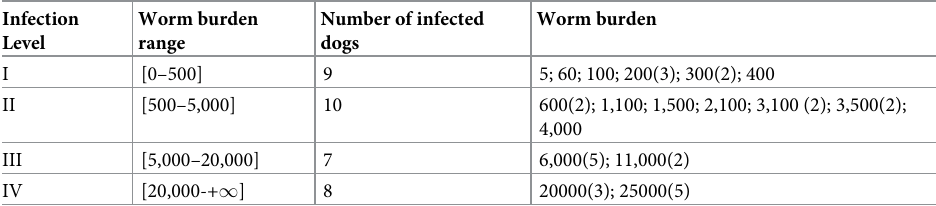
Table 2. Specific parasite burden in the positive samples (n = 34).